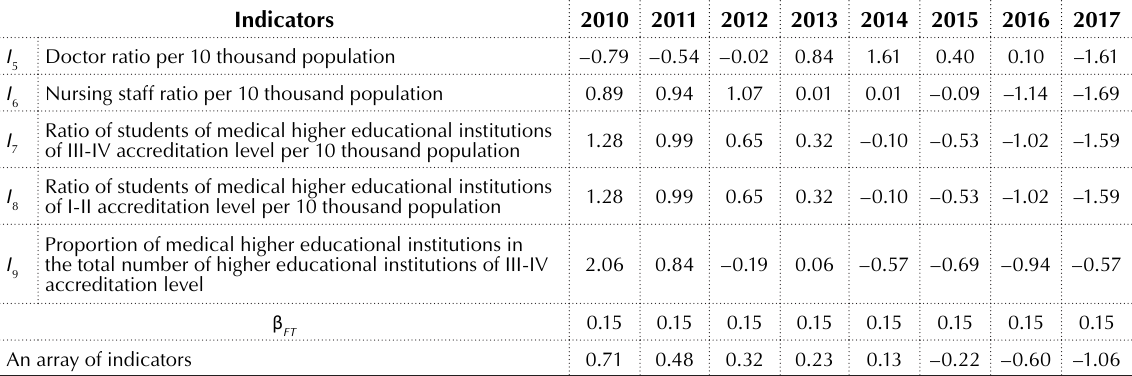
Table 5. Calculation of the socio-economic potential of health insurance/an array of indicators of the human resource management of socio-economic potential (specified values) Indicators